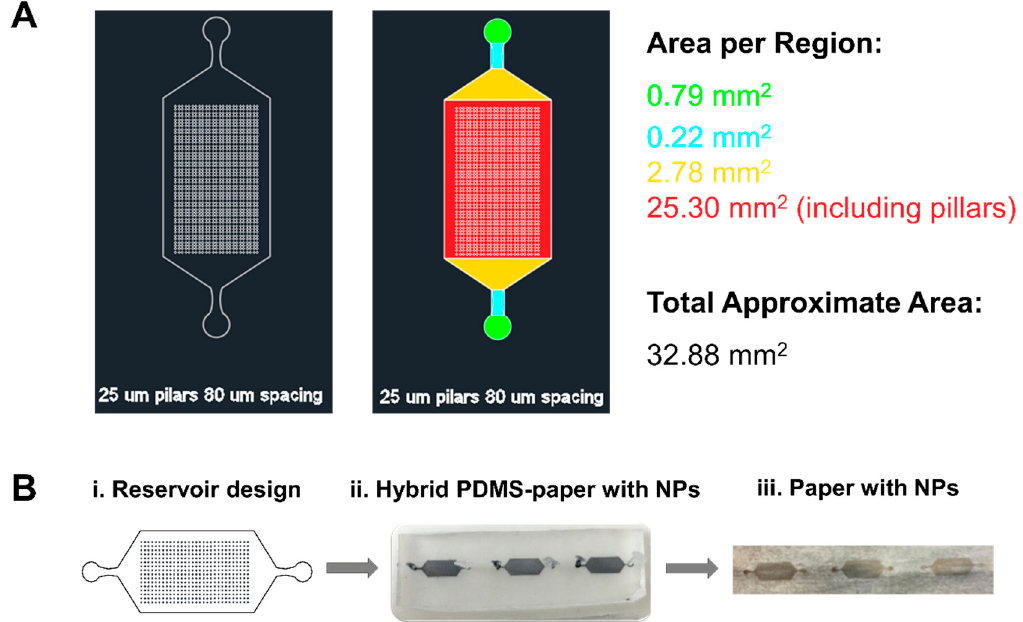
Figure 3. AutoCAD design showing the total area calculation for the controlled NP self-assembly ( A ) and ( B ) AutoCAD design of the reservoir used for NP assembly (i), PDMS-paper after NP injection (ii), paper showing the assembled NPs after de-bonding the PDMS (iii).